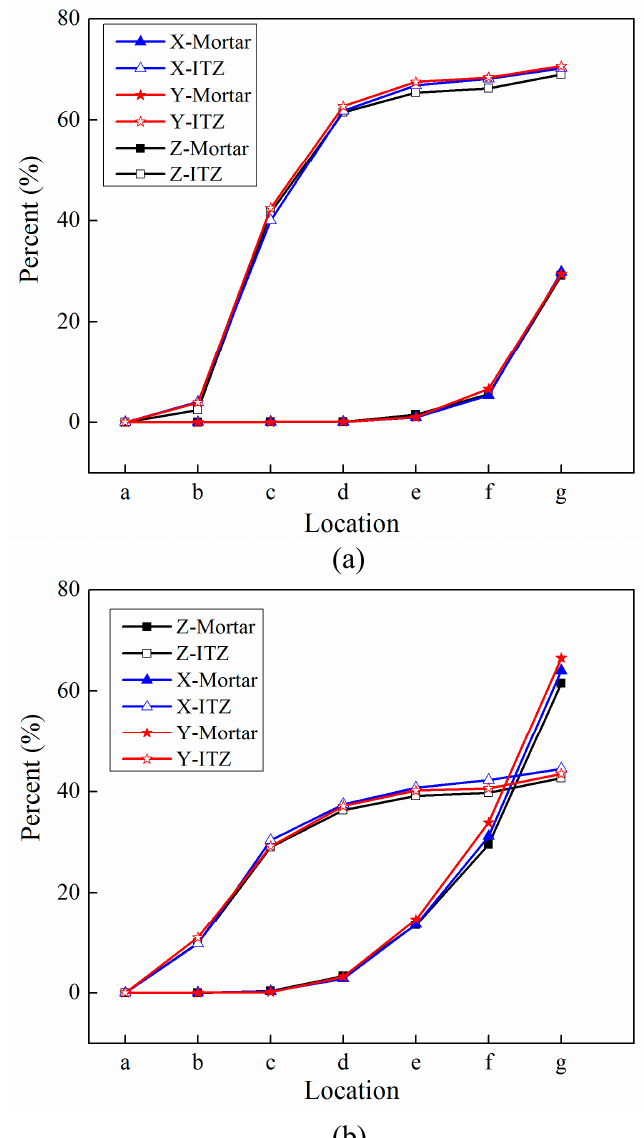
Figure 32. Percentage curves of damaged elements for mortar and ITZ parts under compression: ( a ) Compressive damage, ( b ) tensile damage.